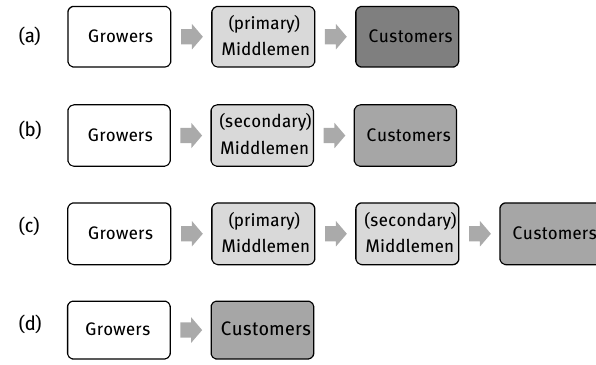
Figure 1: The structure of mulberry supply